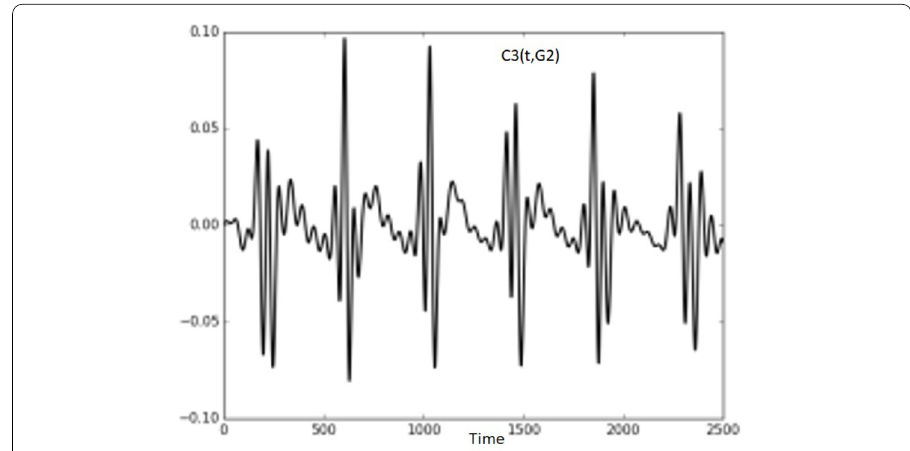
Fig. 34 The third temporal weight by the Galerkin projection upon (cid:9) : c 3 ( t,G 2 )